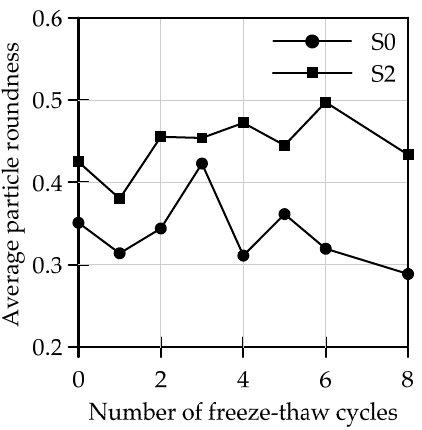
Figure 7. The curve of R and F-T cycles.